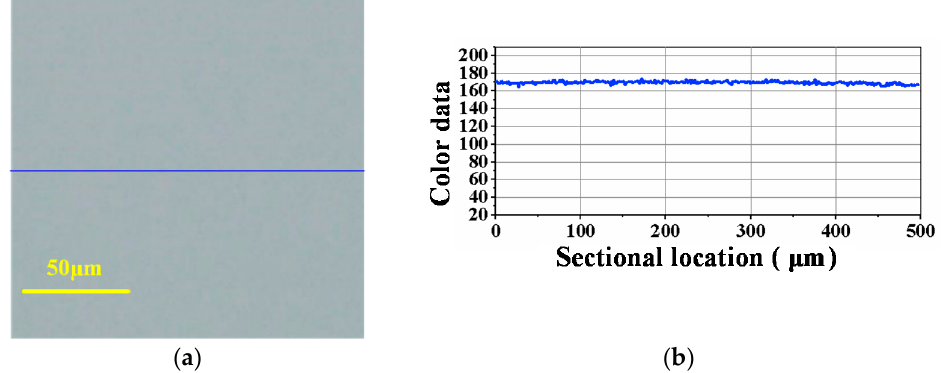
Figure 11. Optical image and sectional surface profile after ultrasonic-assisted CMP using polyure- thane pad (1.44 μ m/h): ( a ) Surface defects; ( b ) Color data of the sectional profile.